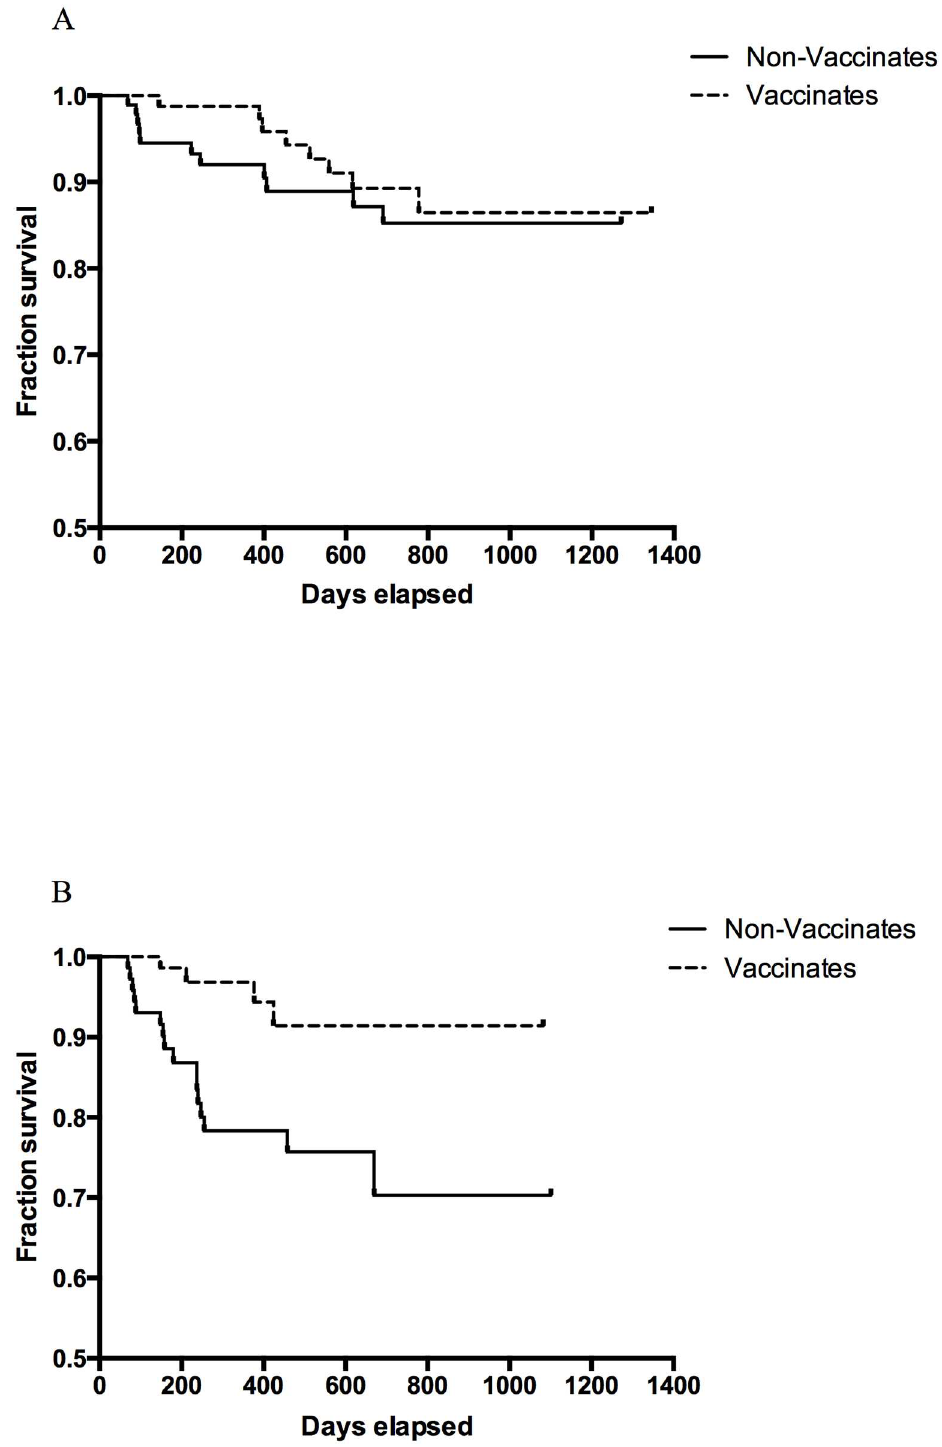
Fig 3. Kaplan-Meier survival curves (time to seroconversion) for non-vaccinated and vaccinated badgers enrolled in sweeps 1–2 (A) and in sweeps 3–6